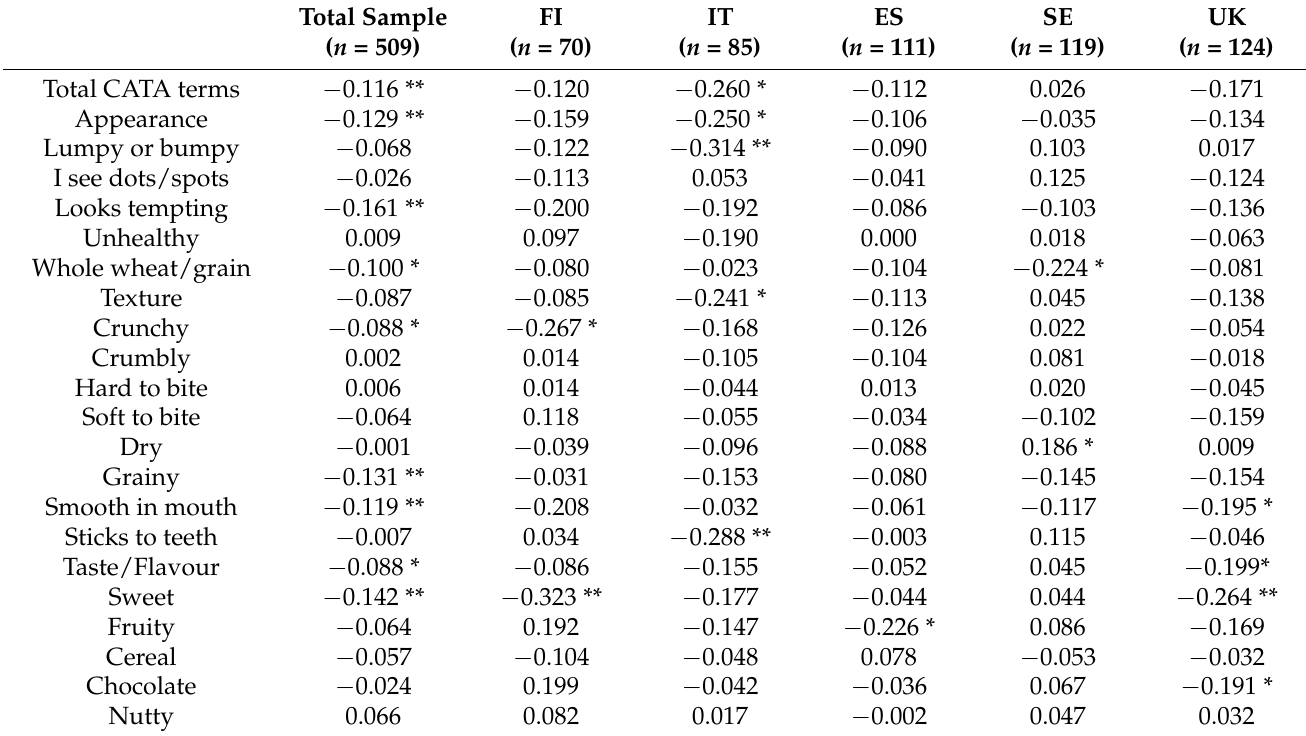
Table 4. Pearson correlations between degree of food neophobia and use of CATA terms in eight biscuits, for the total sample of children and per